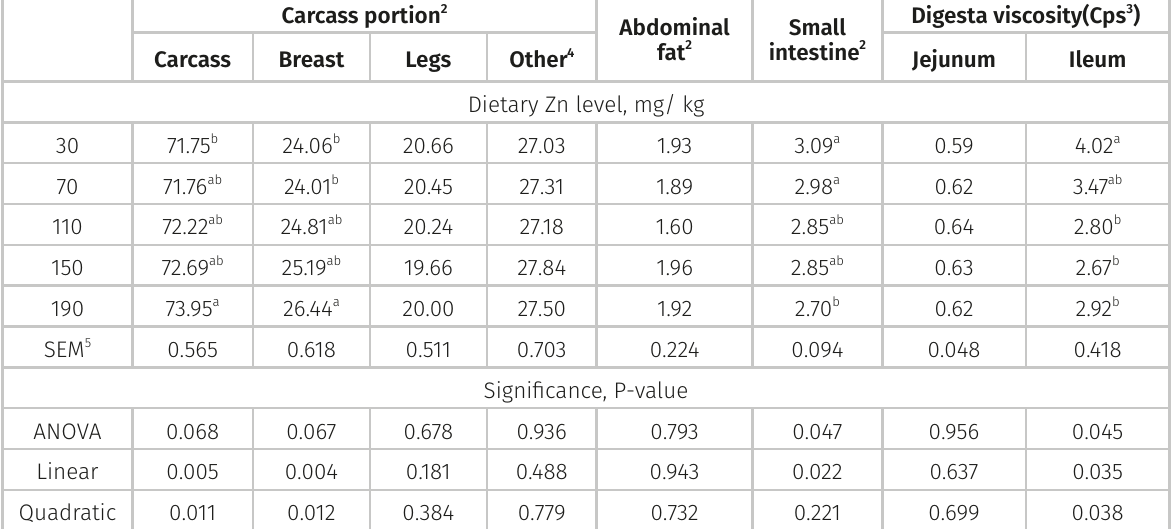
Table V. Effect of dietary Zn concentration on relative weight (g/100g live body weight) of the carcass, abdominal fat and visceral organs and gut contents viscosity (centipoise) in broiler chickens fed wheat-soy diets 1